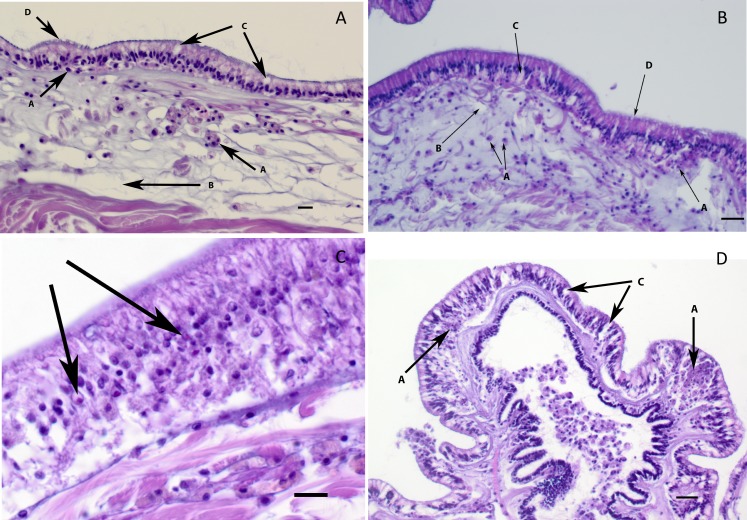
Histological examination of tissues from Forbes Sea stars with SSWD.Representative images with examples of the most characteristic morphological changes to tissues and cells associated with SSWD, as indicated by arrows. (A) and (B): Early stages of infection characterized by an influx of hemocytes (a) in the dermis and in the epithelium underlying or between epithelial cells, oedema of the tissues (b) and early intra- and intercellular vacuolation of the columnar epithelium and cuticular disruption (d). (C) Larger magnification of an area in the epidermis showing pink round to irregular inclusions that were sometimes noted in the vacuolated nuclei of affected epithelial cells (thicker arrows). (D) Moderate to severe changes in the epithelium and dermis of this papilla characterized by intra-epithelial accumulation of necrotic and intact hemocytes (a), intra and inter-cellular vacuolation of the columnar epithelial cells (c) and dermal oedema (6 μm, H&E stained paraffin section; bar = 30 μm).